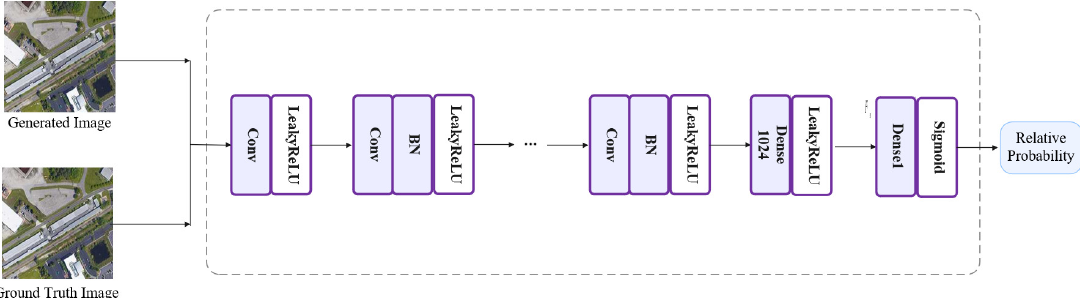
Figure 9. The architecture of the discriminator module.